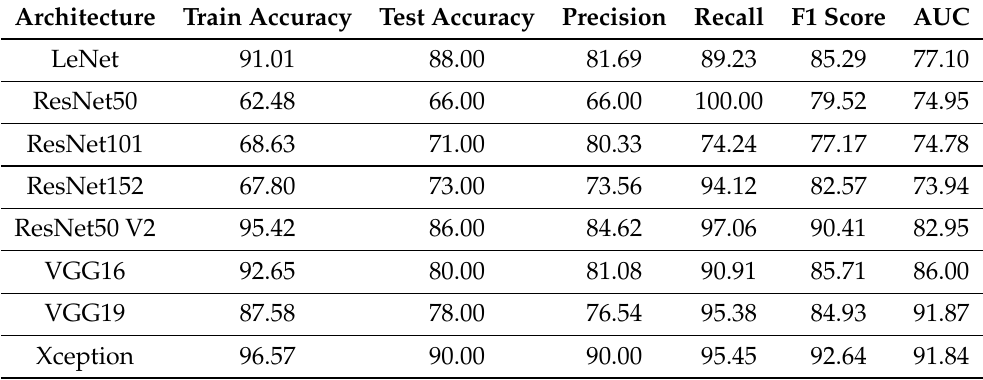
Table 3. Evaluation metrics expressed as %.